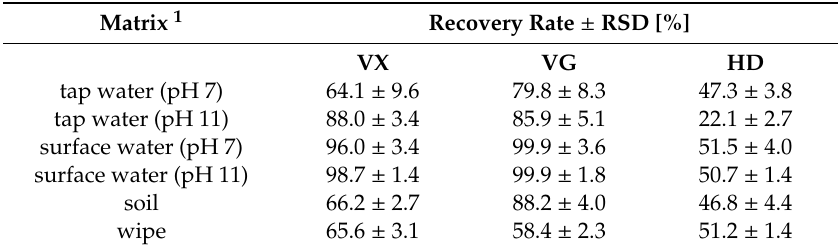
Table 2. Results of the automated extraction of chemical warfare agents VX, VG and HD at 5 s extraction time and 1200 rpm vortex speed.